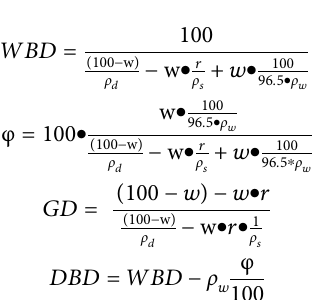
sediment water content ( w , in wet mass%), densities, organic carbon, carbonate, and biogenic silica, as well as the calculation of mass accumulation rates. About 10 cm 3 of sediment material were taken for these analyses, freeze-dried and milled. Density of the dried sediment samples ( ρ d ) were measured with Micromeritics AccuPyc 1,330 gas-pycnometers. Wet bulk density ( WBD ), porosity ( φ , vol%), grain density ( GD ), and dry bulk density ( DBD ) were calculated according to equations